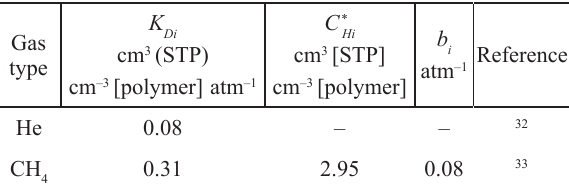
Table 1 – Parameters required for defining the partition co- efficient of helium and methane in Hyflon